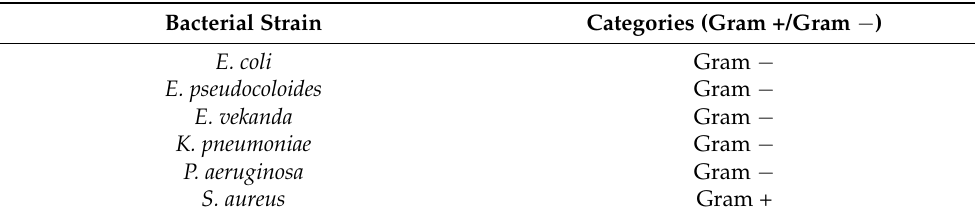
Table 5. Bacterial strains used in this study and their